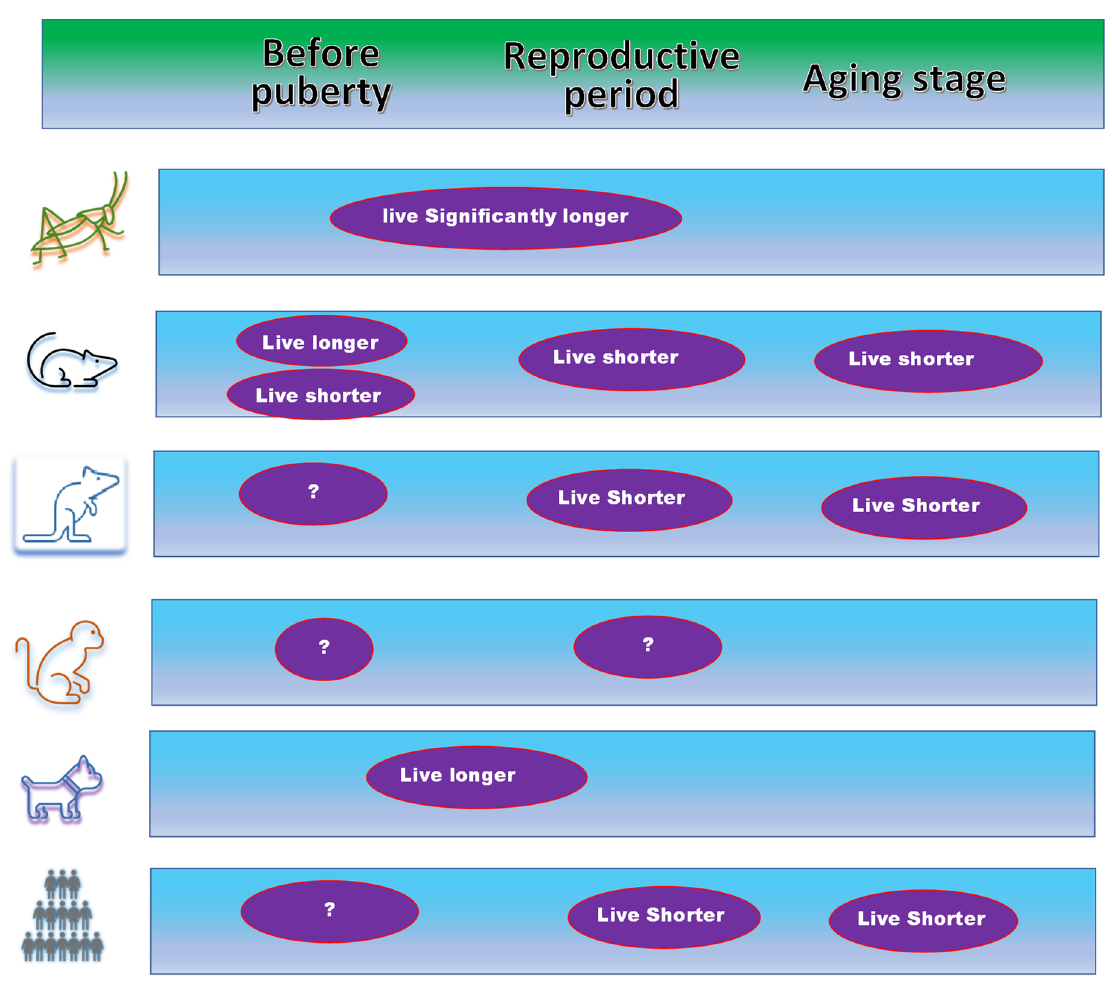
Figure 4. Current status of the studies of estrogen levels with oophorectomy in animal and human populations. Oophorectomy performed during reproductive and aging stages causes complications and leads to a shorter lifespan in mouse, rat, and human populations. Oophorectomy in grasshoppers extends the lifespan. In dogs, the lifespan is also extended or is not shortened when the oophorectomy is performed most likely before puberty. There are conflict reports on the impact on the lifespan when the oophorectomy is performed before puberty. More studies should be done with animals, in particular with monkeys.